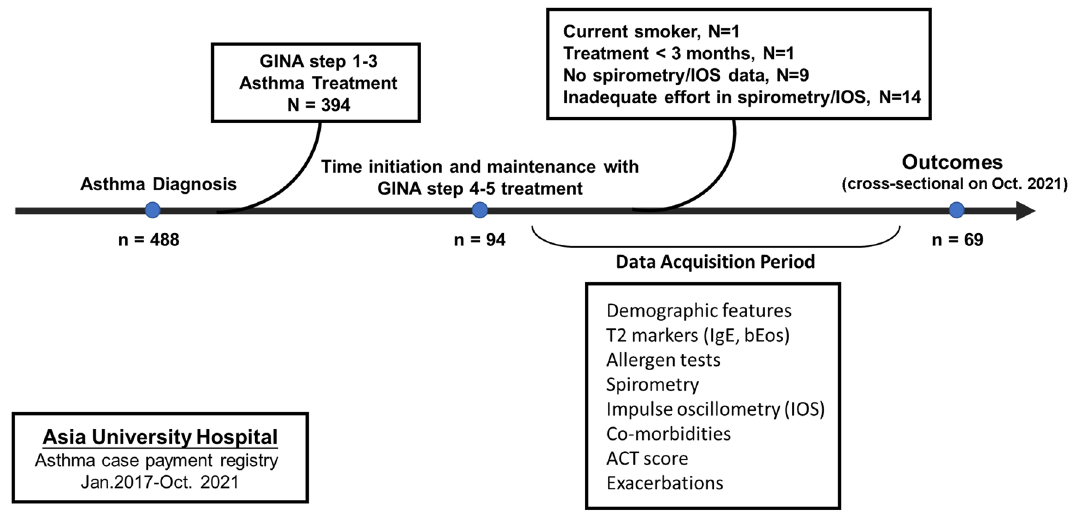
Figure 1. Flow chart for study population. Abbreviation ACT, Asthma Control Test; bEos, blood eosinophil level after asthma treatment with steps 4–5; GINA, Global Initiative for Asthma; IOS, impulse oscillometry